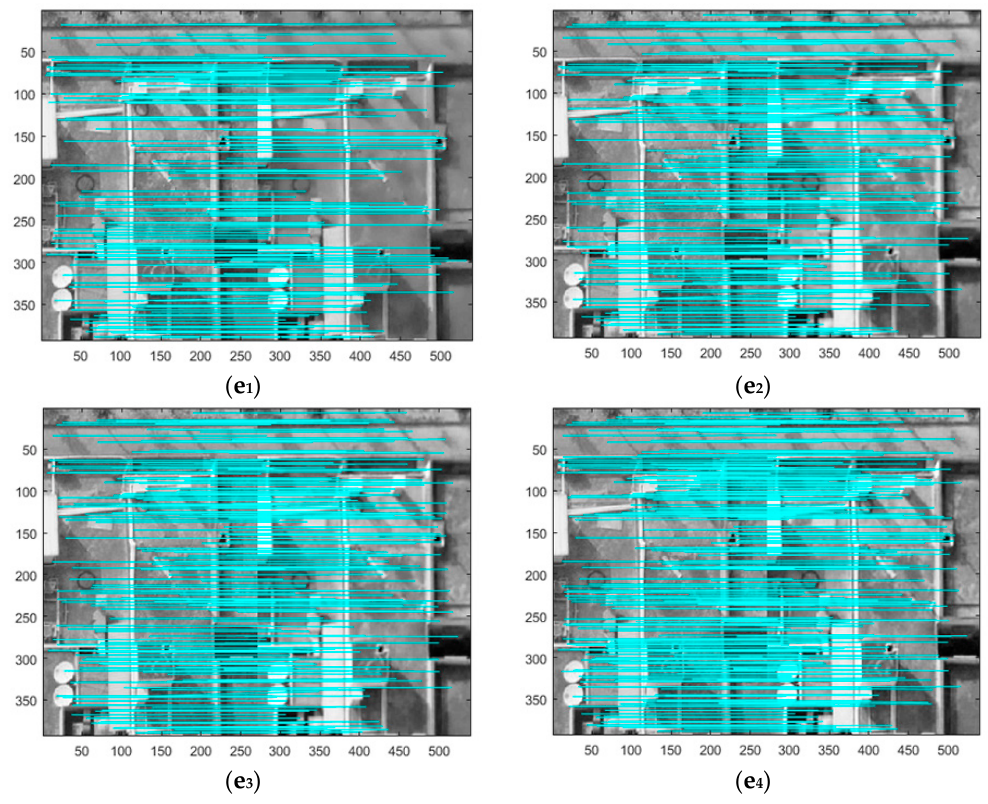
Figure 4. Due to the length concerns, we only show the matching results of 3 images ( b , c , e ). In each matching image, the left image is the original real clean UAV image, and the right image is the denoised UAV image (noise level 35). The 1st image ( b 1 , c 1 , e 1 ) presents matching results from SIFT and the denoised UAV images using method [8] and original real clean UAV images. The 2nd image ( b 2 , c 2 , e 2 ) presents matching results from SIFT and the denoised UAV images using method [5] and the original real clean UAV images. The 3rd image ( b 3 , c 3 , e 3 ) presents matching results from SIFT and the denoised UAV images created by method [17] and original real clean UAV images; and the 4th image ( b 4 , c 4 , e 4 ) presents matching results from SIFT and the denoised UAV images using proposed method and the original real clean UAV images.